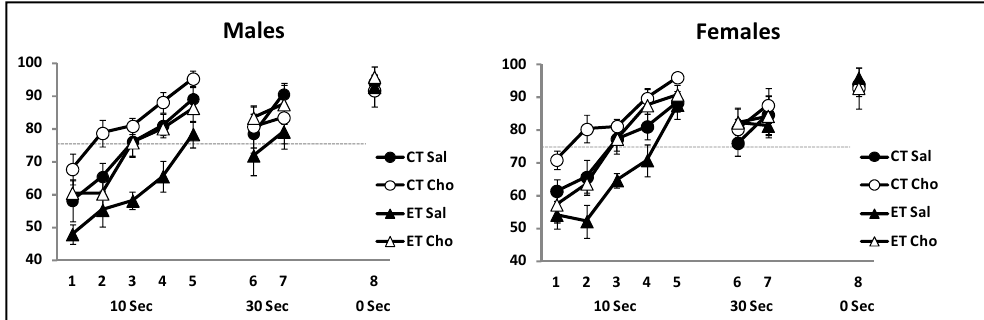
Figure 1. Delayed non-matching to place acquisition data for male and female rats trained on P30–P38. Rats were trained in a T-maze with one 12 trial session each day. The first five daily sessions used a 10 s delay between the demonstration and test trial. The majority of rats reached a criterion of 75%, indicate 3d by the dashed line, by day 5. After this the delay was increased to 30 s for two sessions. Rats were then tested with no retention delay to confirm acquisition of the non-matching rule. Each data point represents the Mean ± SEM. CT = Control, ET = Ethanol; Sal = Saline, Cho = Choline. n = 7–9 per group.